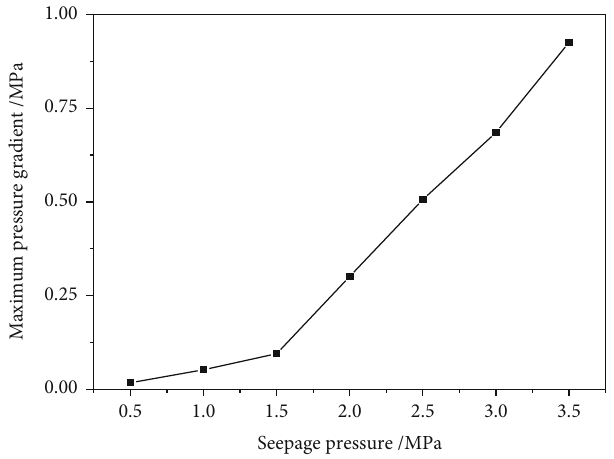
Figure 8: Relationship curve of the highest-pressure gradient in the fl uid grid and the seepage